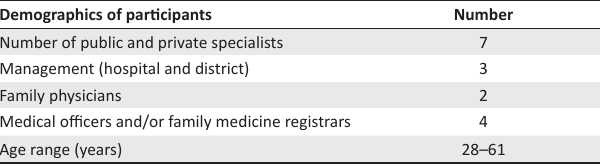
TABLE 1: Demographics of study participants.